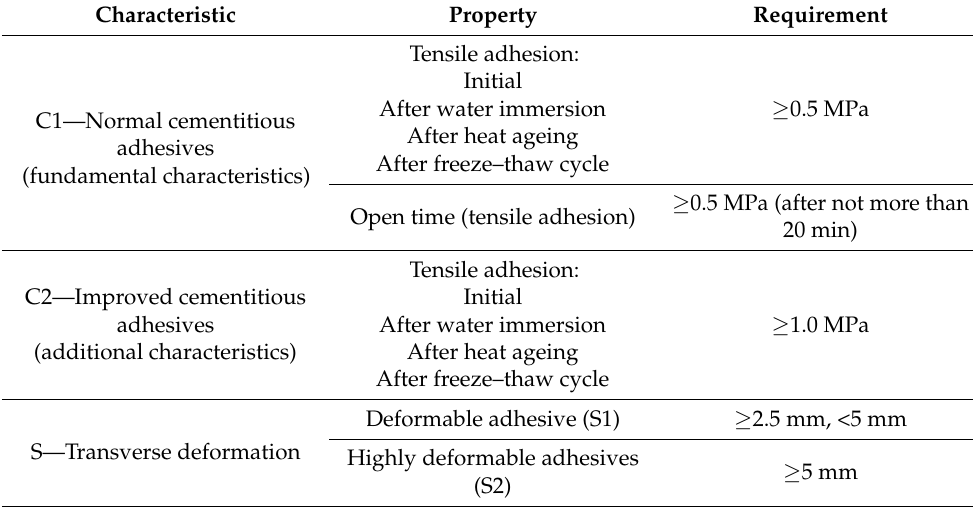
Table 1. Summary of specifications for cementitious adhesives, including fundamental and special characteristics